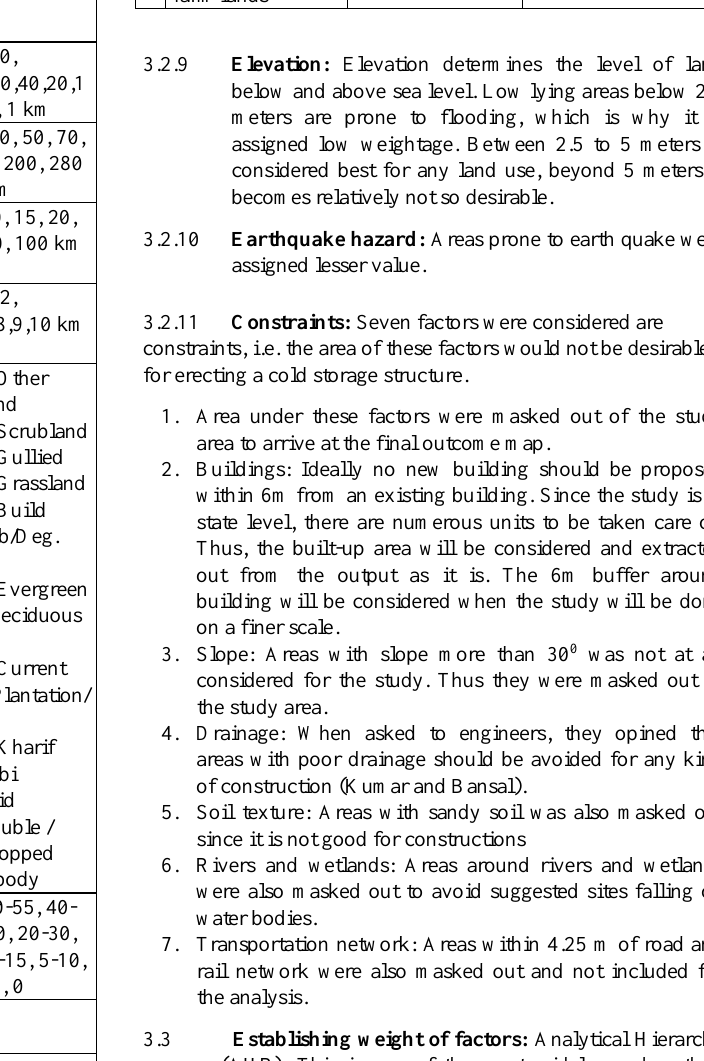
Table 2. Factors considered for site selection for cold storages